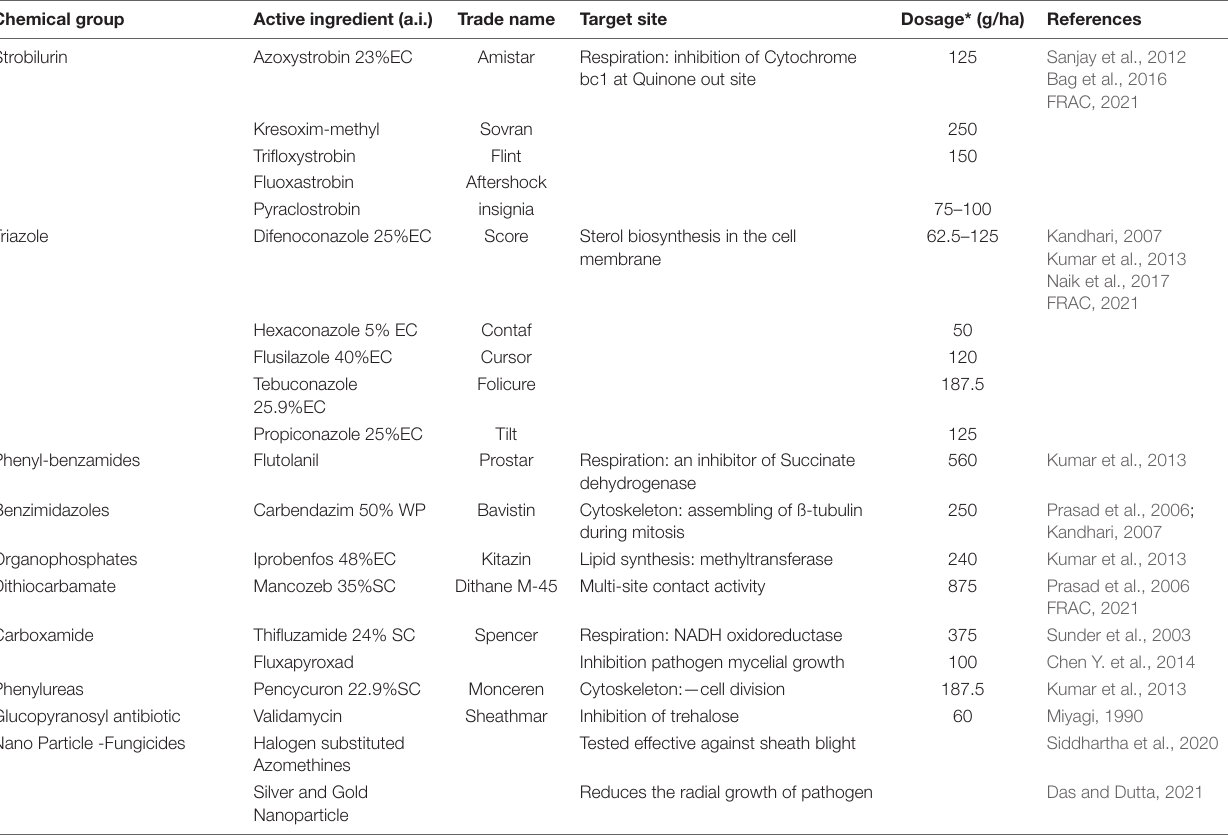
TABLE 2 | List of commercially used chemicals for managing sheath blight disease of rice. Chemical